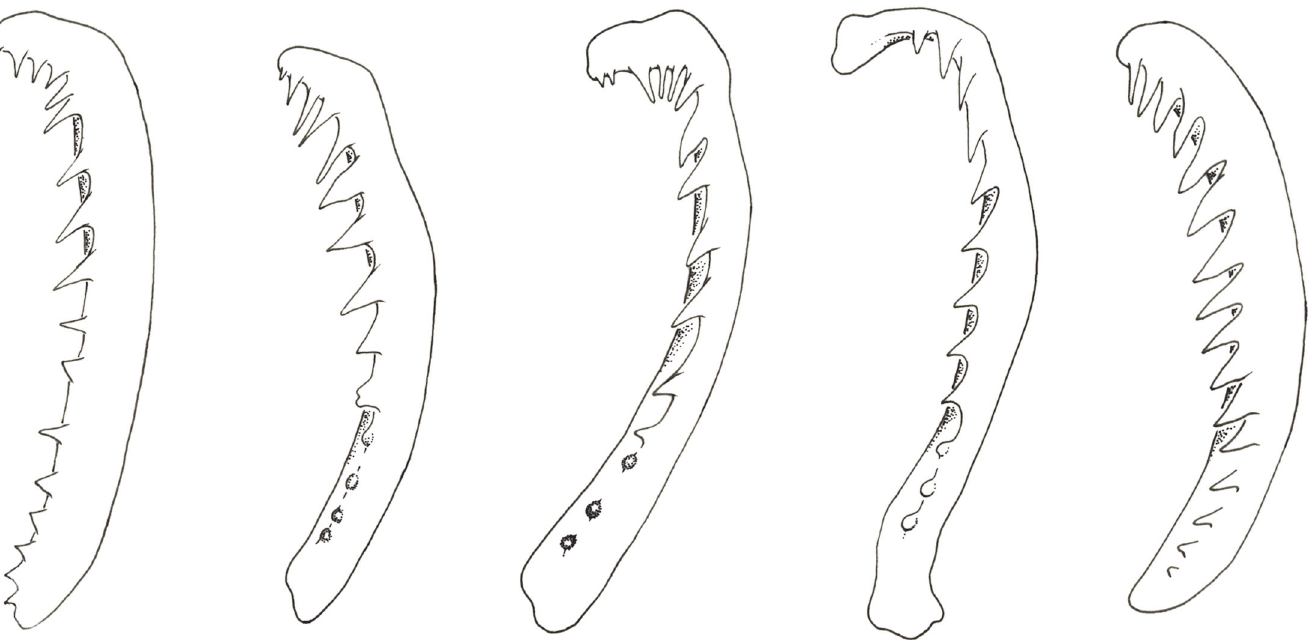
Fig 3. Gill arches of Simochromis and Pseudosimochromis species. From left to right: P . curvifrons , S . babaulti , S . marginatus , S . margaretae and S . diagramma . Specimens illustrated are listed in Appendix.